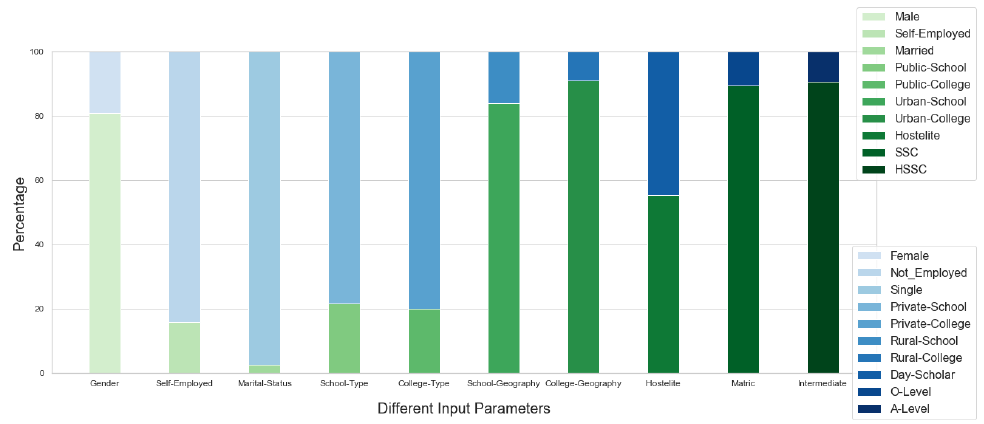
Figure 4. Different Input Parameters.